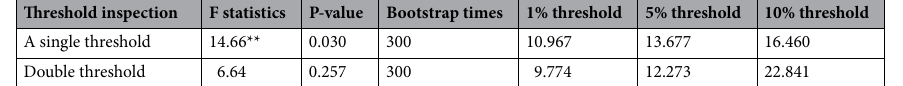
Threshold inspection